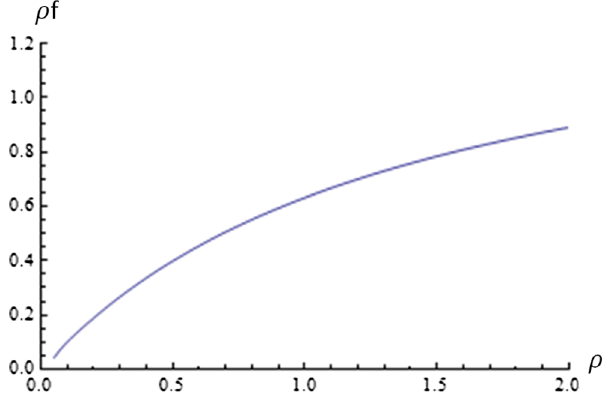
FIG. 5. ρ f increases as a function of ρ .